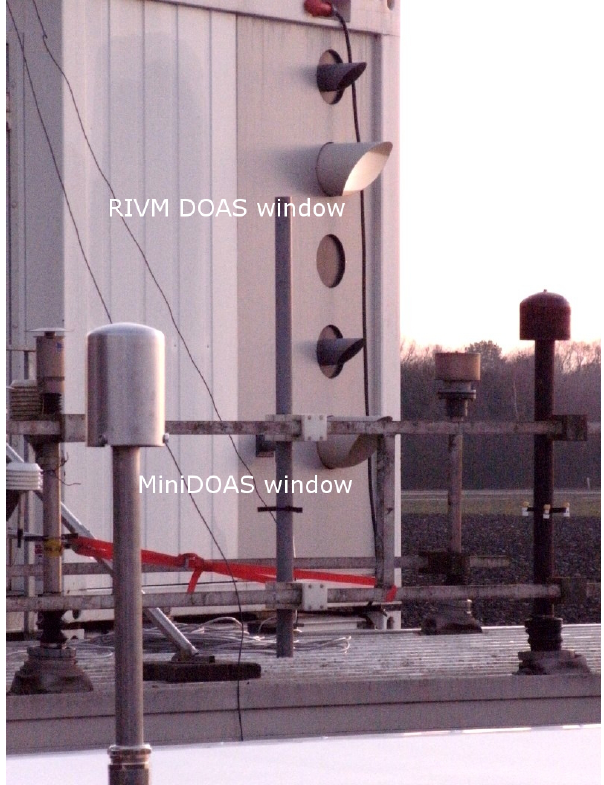
Fig. 12. Photo of measurement cabin with the two windows, of the RIVM DOAS (upper window, with light emerging) and the miniDOAS (lower window, partly hidden by a metal rail). The light of the lamps are directed directly over the inlet of the AMOR instrument inside the LML measurement cabin.